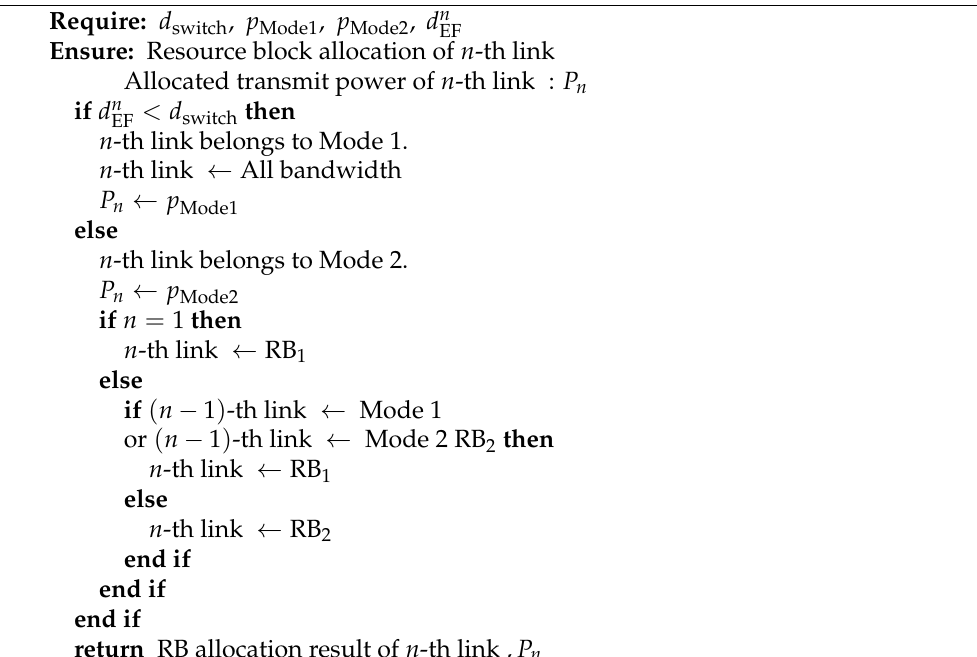
Algorithm 1: Distributed Resource Block Allocation Scheme for V2V with